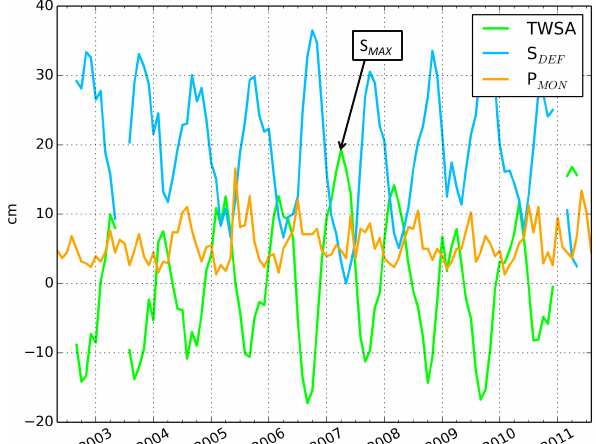
Figure 1. Variations of total water storage anomaly (TWSA, green line), monthly precipitation ( P MON , blue line) and water storage deficit ( S DEF , yellow line) at the grid cell (52.5 ◦ N, 117.5 ◦ W) dur- ing the study